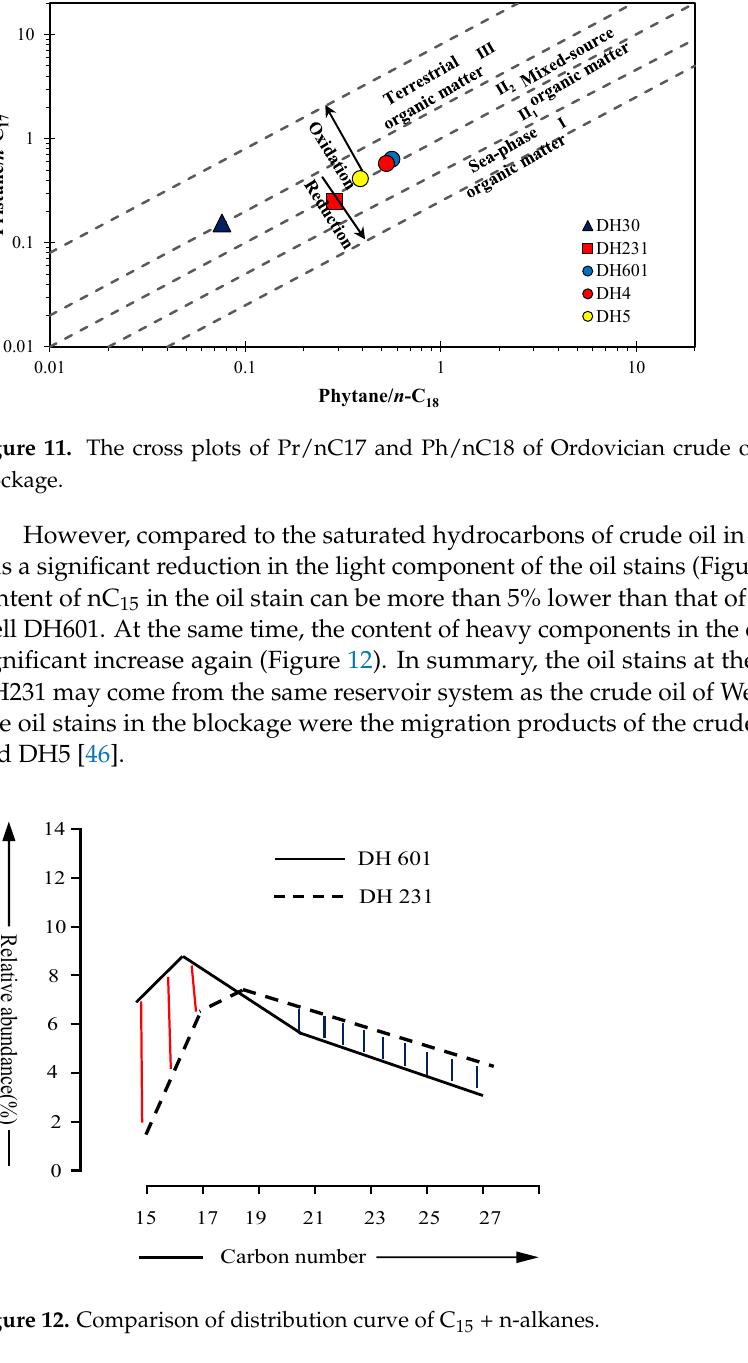
Figure 10. The composition of steranes and terpenoids in the blockade and its comparison with crude oil from adjoining wells .